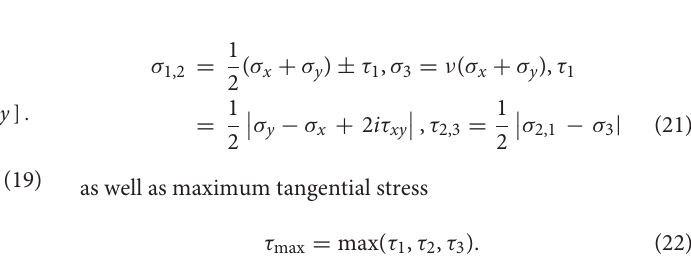
In addition, we find the principal normal σ 1 , σ 2 , σ 3 and tangential τ 1 , τ 2 , τ 3 stresses (Timoshenko and Goodyear, 1979)